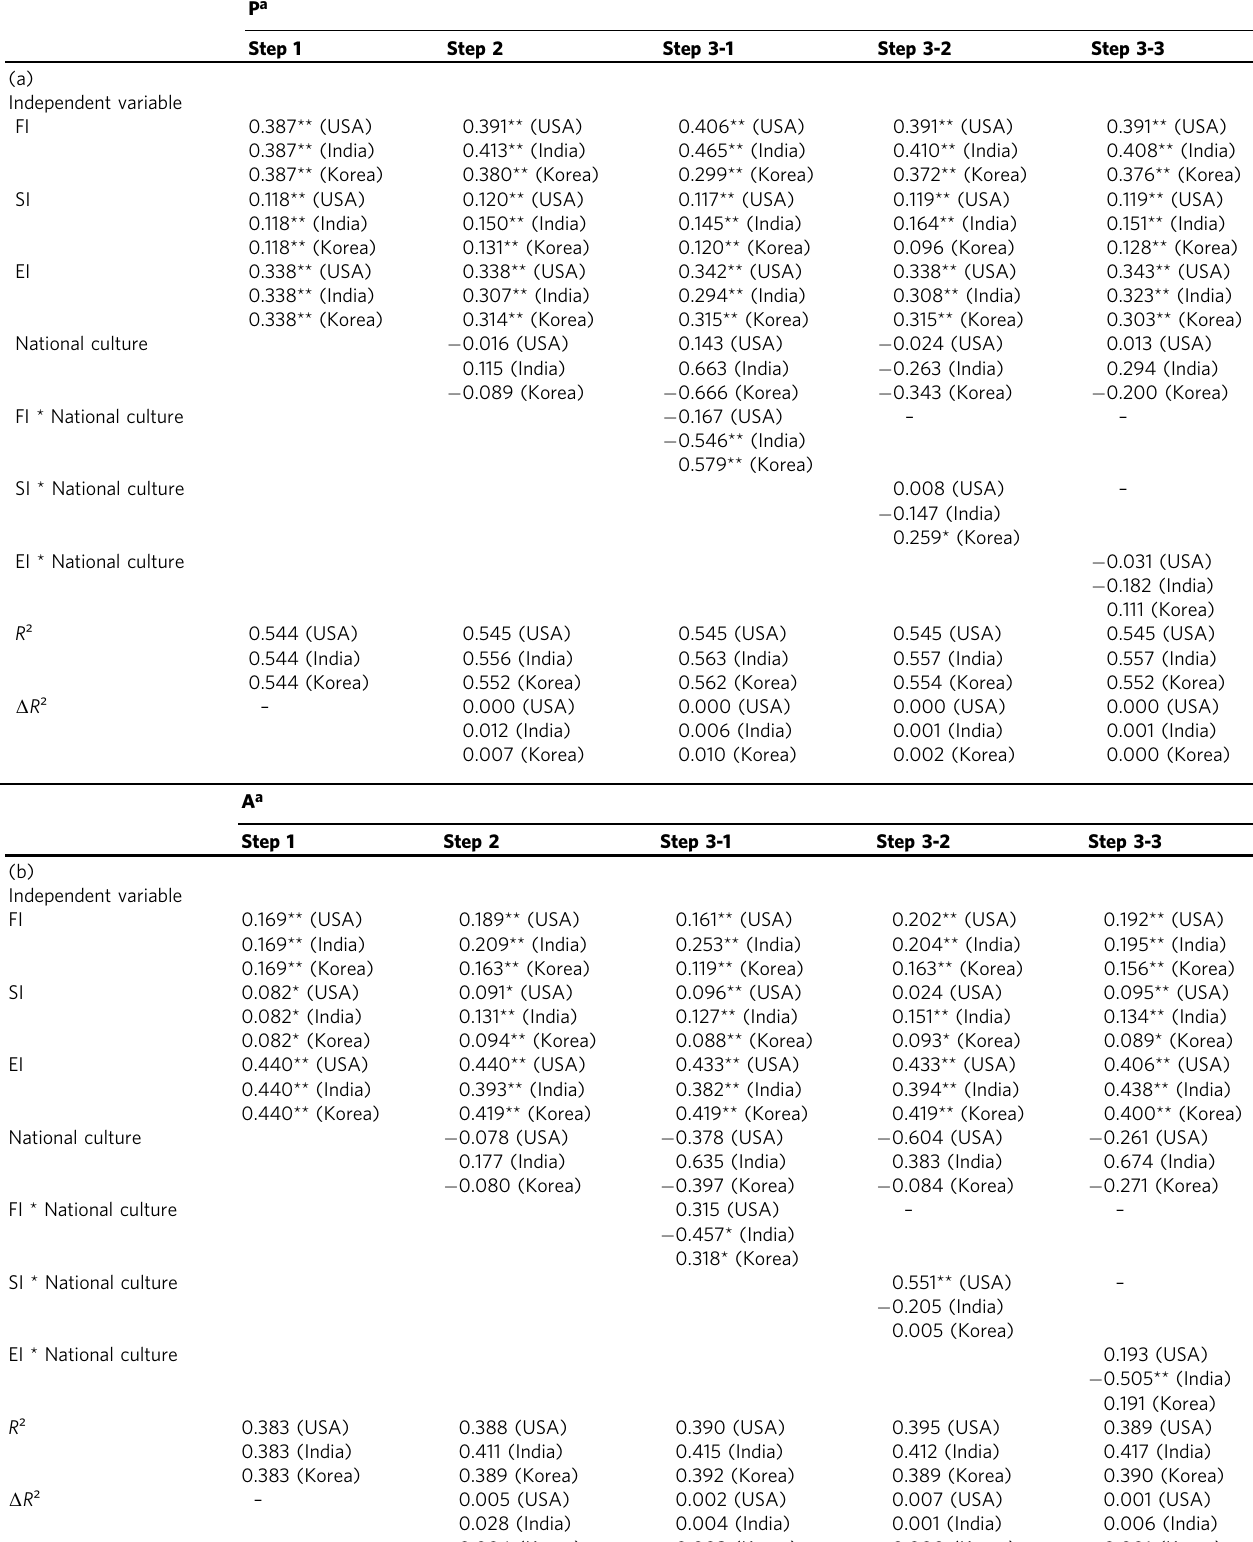
Table 5 Hierarchical regression analysis for moderating role of national culture: (a) pleasure, (b) arousal, (c) place identity, and (d) revisit